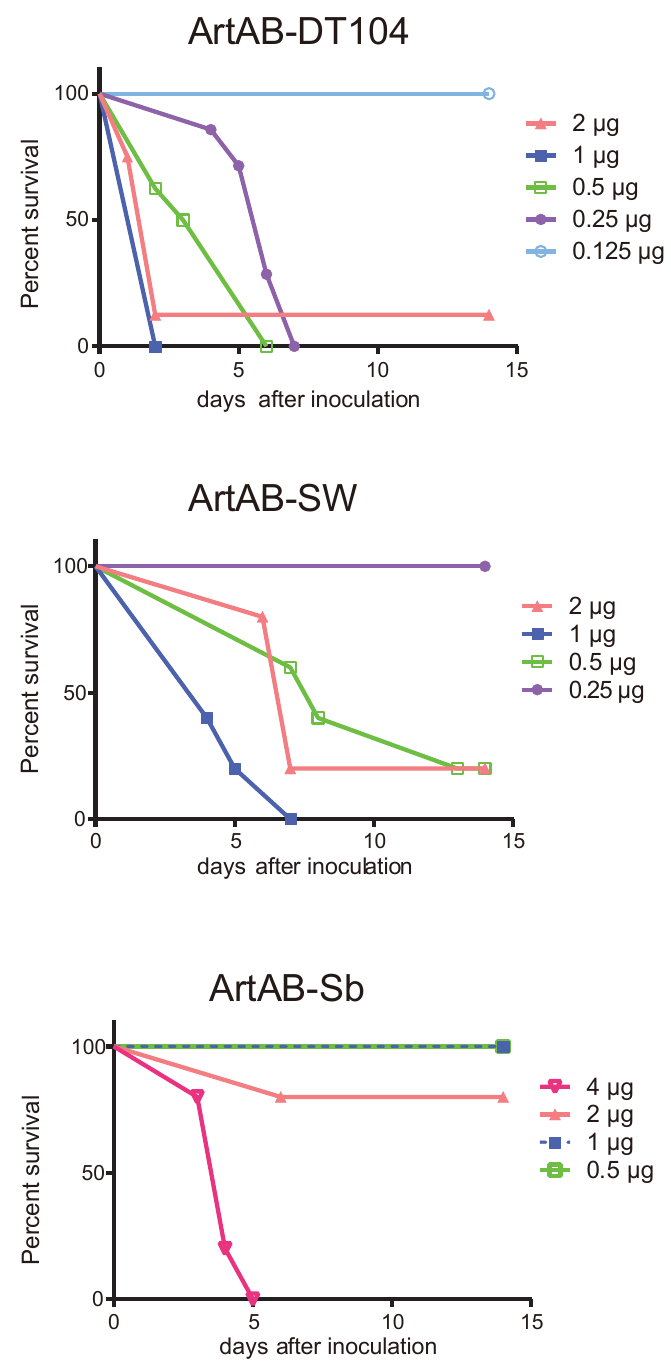
Figure 3. Percentage of surviving mice following challenge with indicated amounts of ArtAB over time. BALB/c mice (n = 5–8) were challenged with graded doses of ArtABs (ArtAB-DT104, ArtAB-SW, or ArtAB-Sb) and observed daily over a 2-week